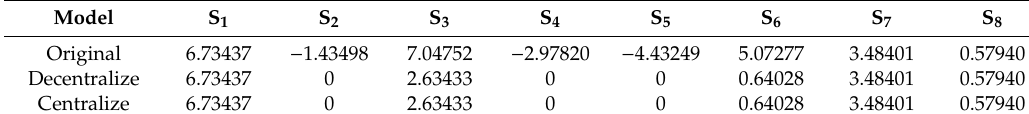
Table 4. Feeder power before and after regulation under case 2 (MW).